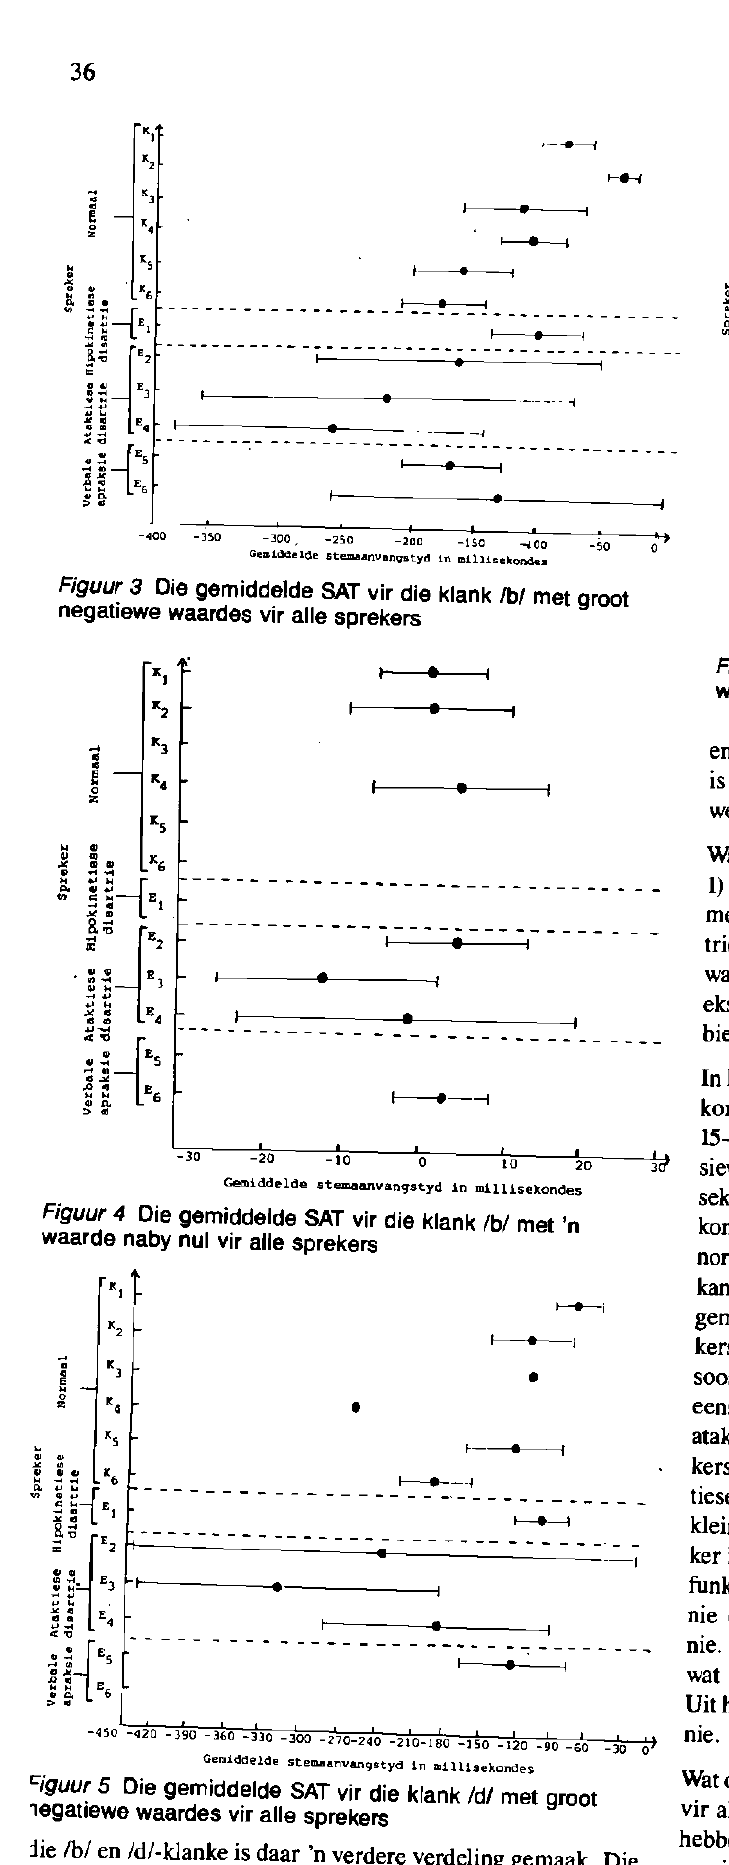
α α ι. μ « α > α -450 -420 -390 -360 -330 -3 -300 -2/0-240 -210-180 -150 -120 - 90 - 60 - 30 ο* Gemiddelde stemaanvangstyd In mllllaekondes *iguur 5 Die gemiddelde SAT vir die klank /d/ met groot negatiewe waardes vir alle sprekers iie /b/ en /d/-klanke is daar 'n verdere verdeling gemaak. Die " e de hiervoor is dat tydens die metings van /b/ en /d/ dit opval- end was dat daar soms 'n groot negatiewe waarde gemeet is